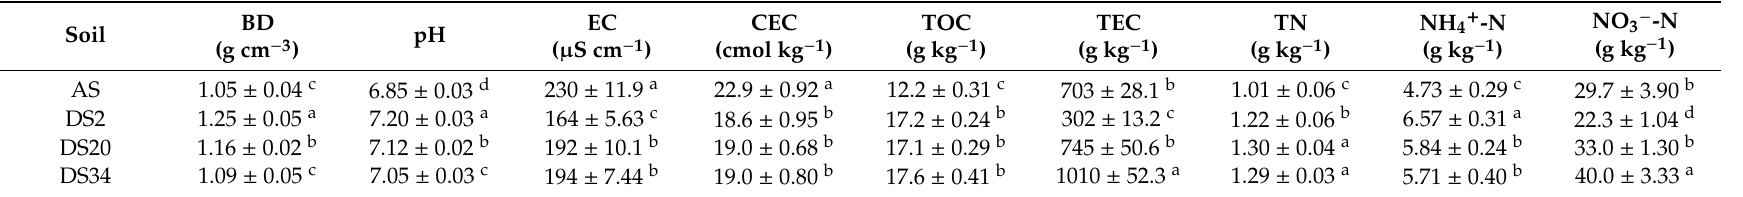
Table 1. Main physico-chemical properties of the arable soil and de-sealed